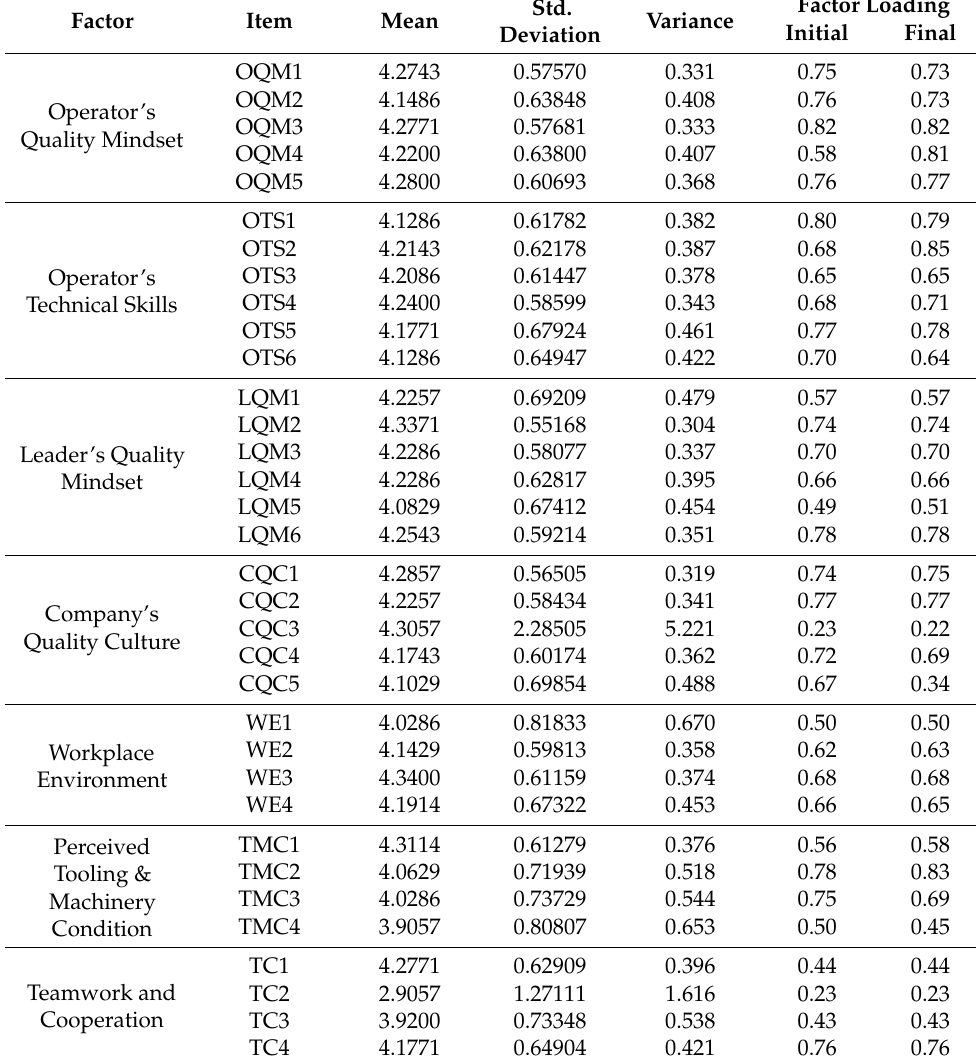
Table 3. Descriptive statistic of